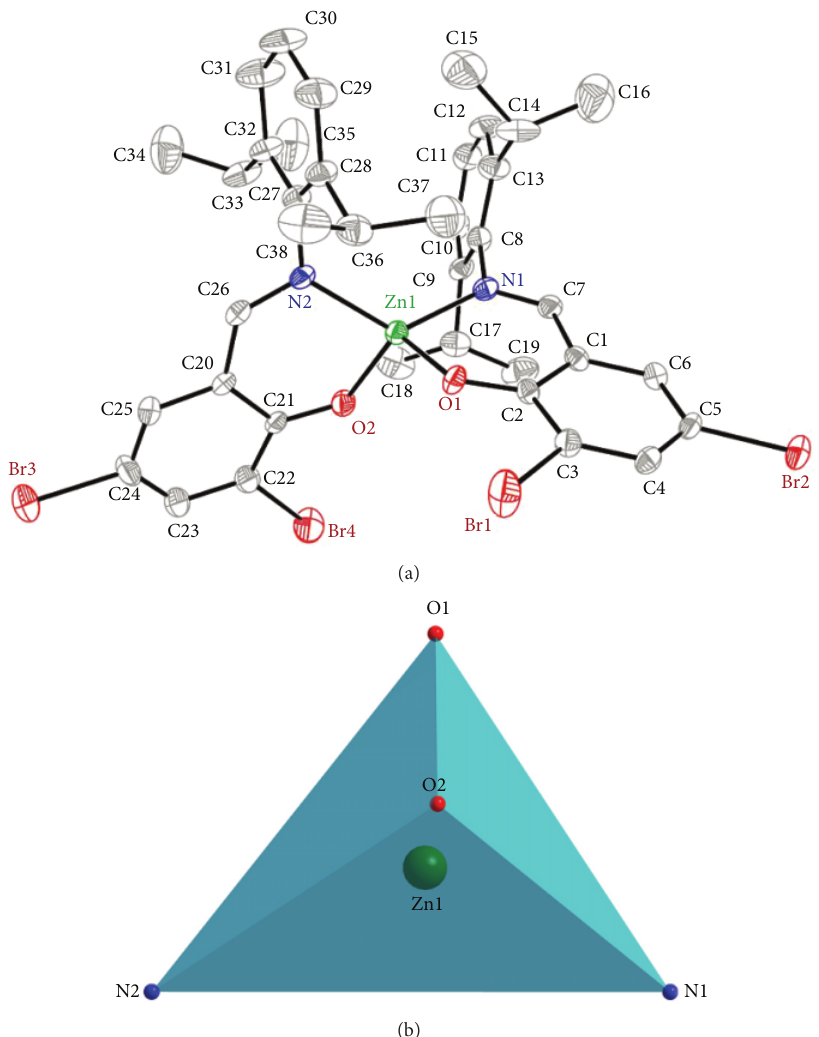
Figure 2: (a) The molecular structure of 2 with numbering scheme (30% probability ellipsoids). All H atoms are omitted for clarity; (b) tetrahedral geometry surrounding the Zn(II) atom of 2 .